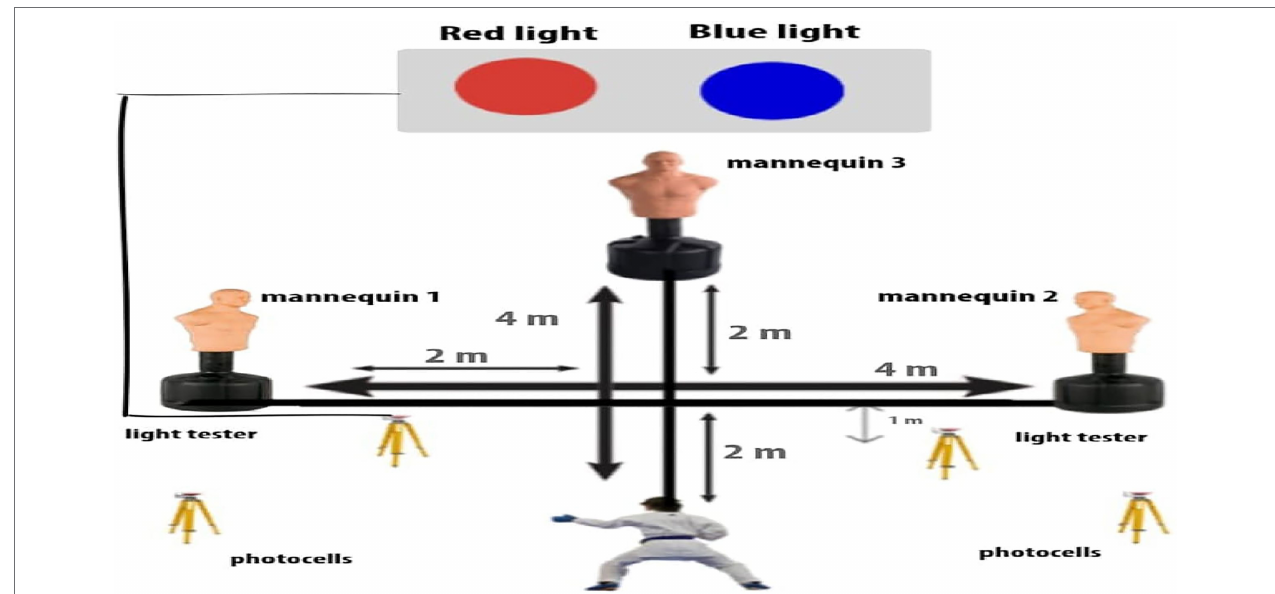
FIGURE 1 | Specific karate agility